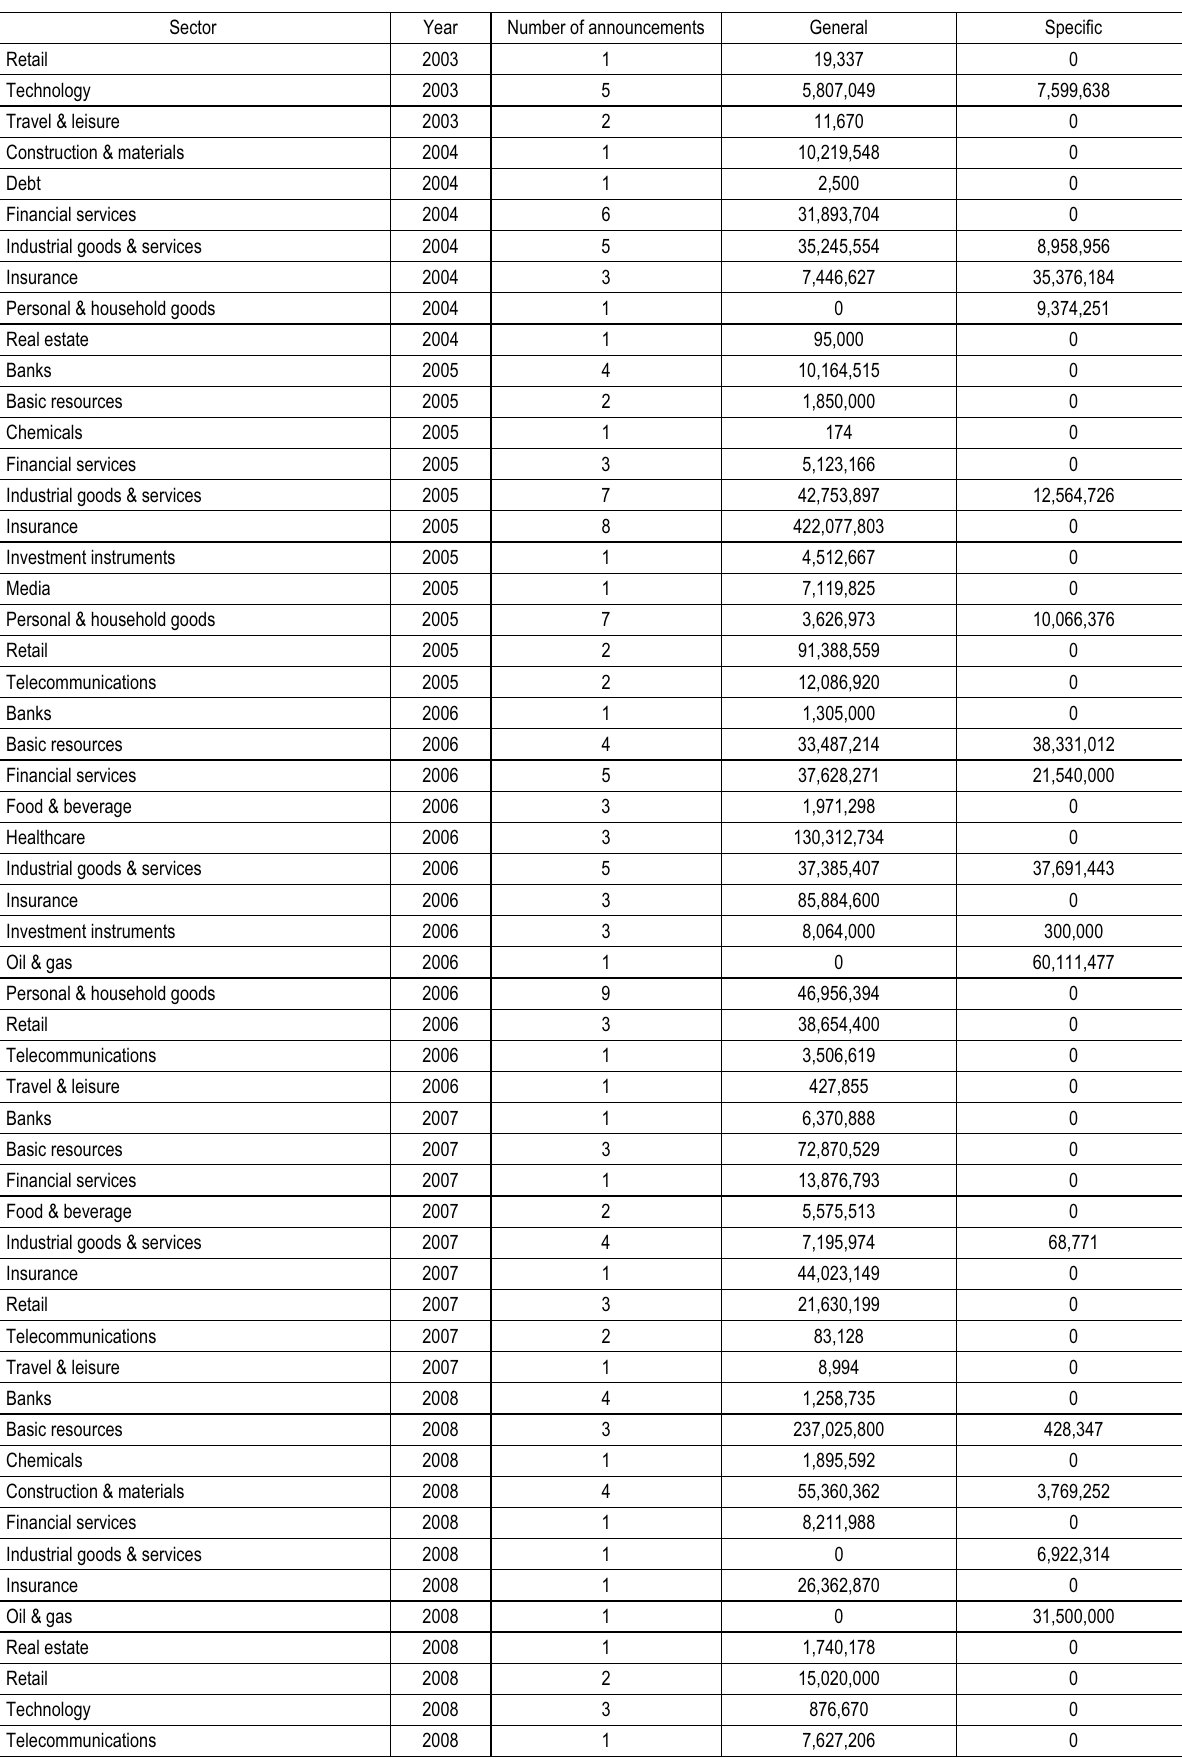
Table 2 (cont.). Total share repurchase announcements per sector per calendar year for the